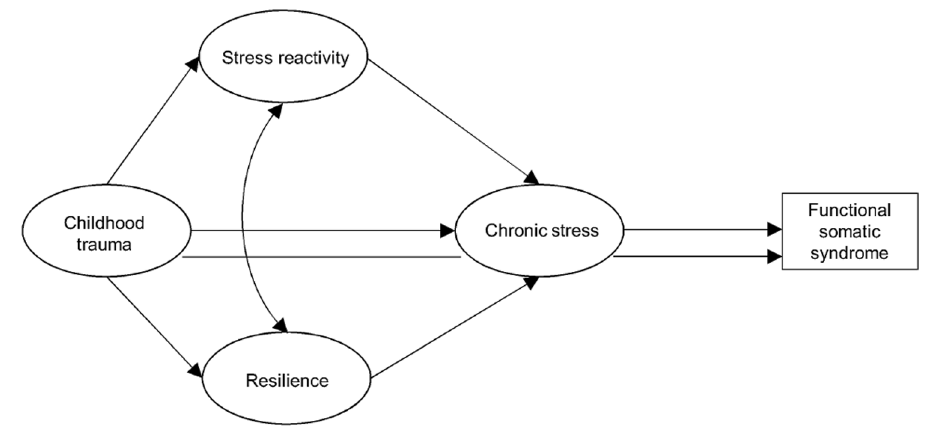
Figure 1. Conceptual model for FSS.